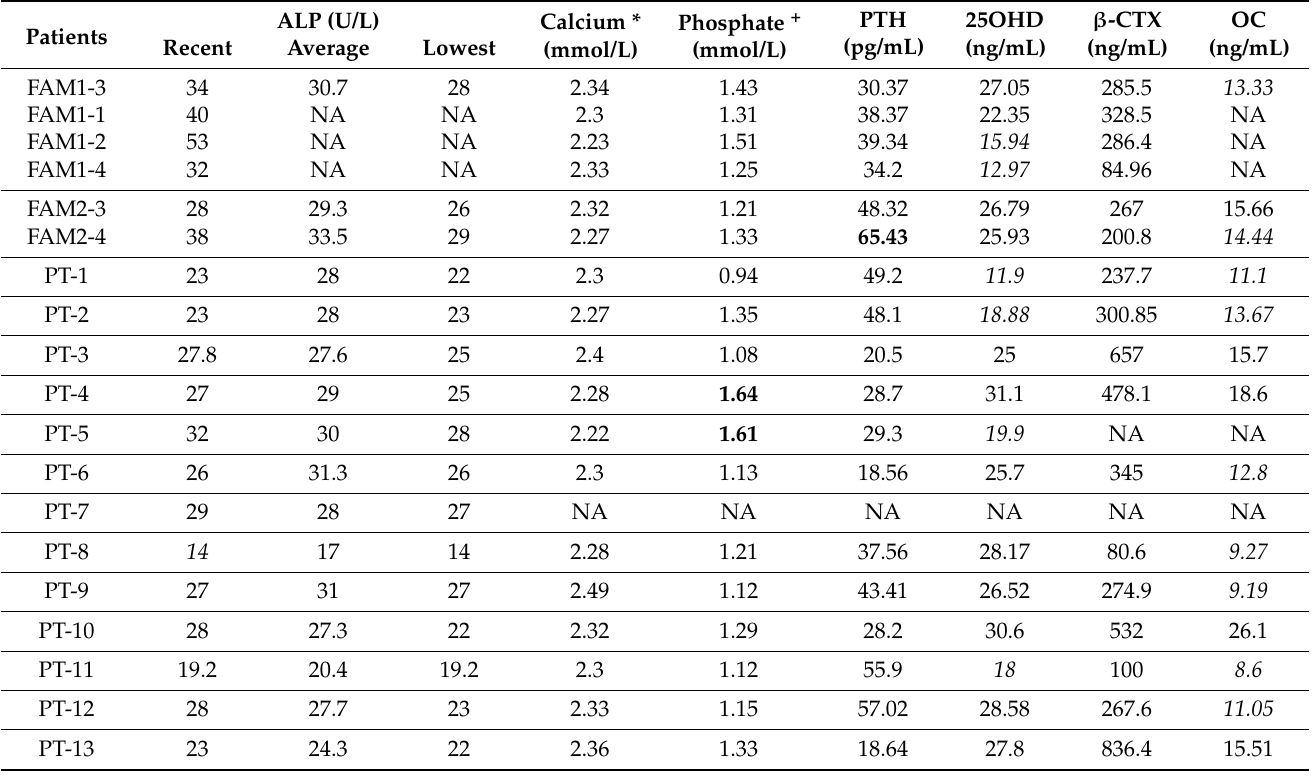
Table 2. Laboratory